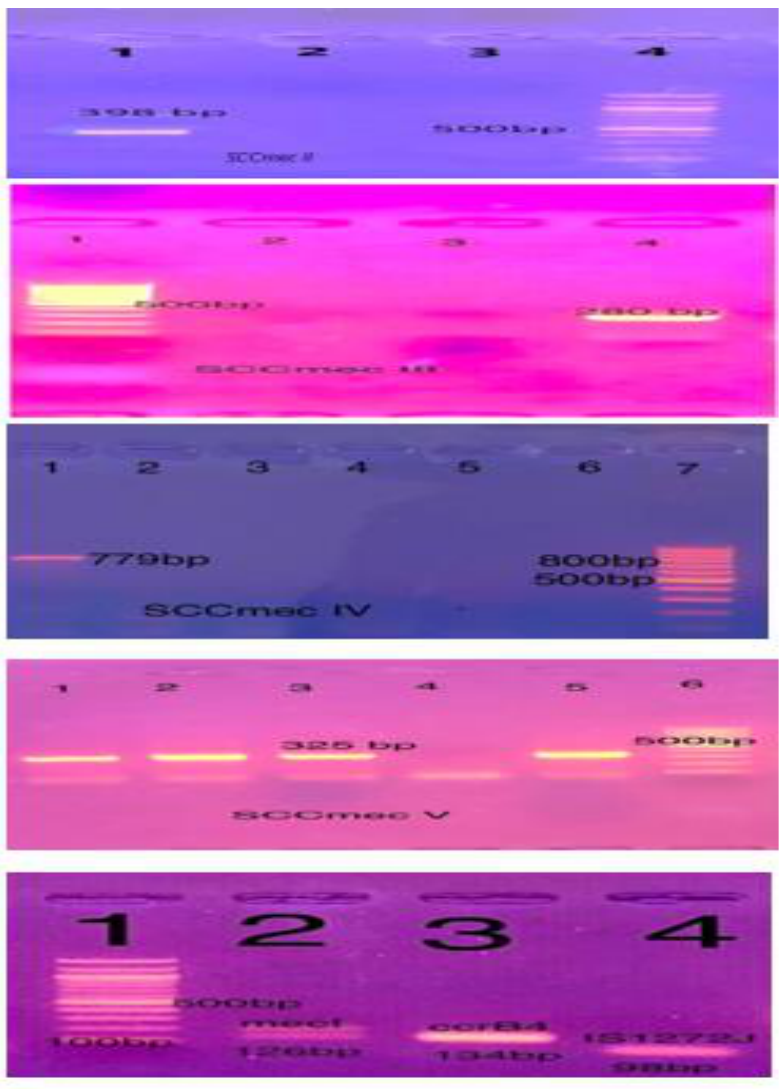
Figure 2. Showing specific band sizes for each SCC mec